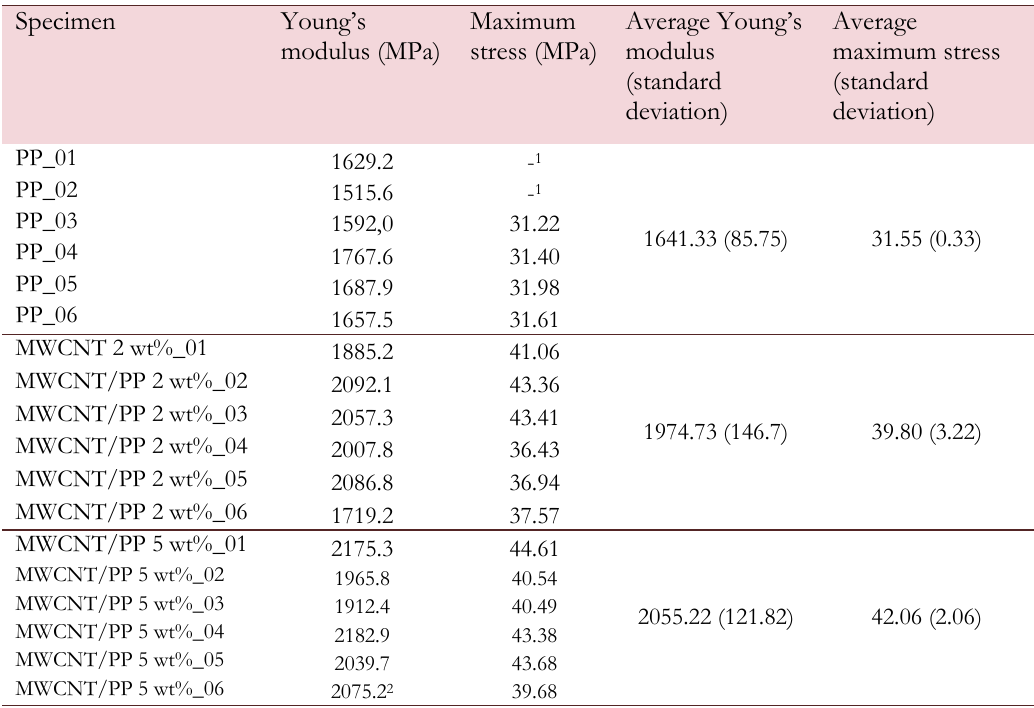
Table 1: Measured mechanical properties of the PP and